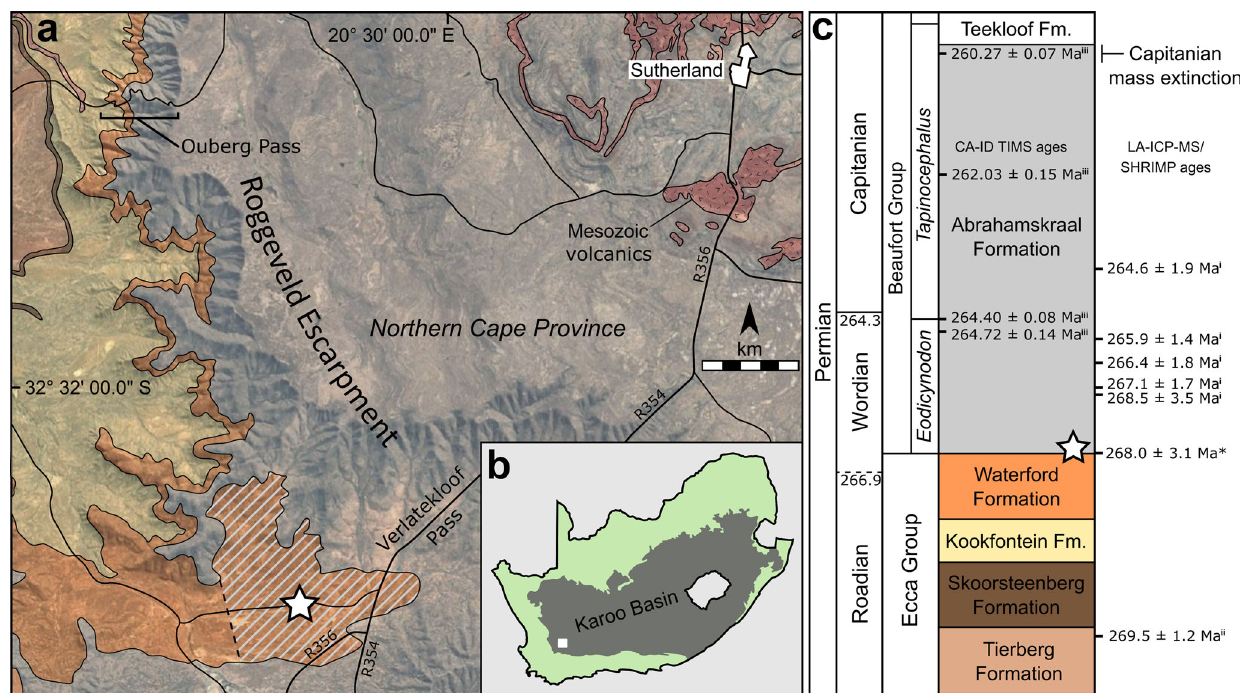
Fig. 2 Map and section showing the position of the Onder Karoo locality. a Geological map showing the Onder Karoo locality (white star) near the foot of Verlatekloof Pass, southwest of Sutherland. The diagonal hatching indicates exposure of probable lower Beaufort Group rocks that appear as Waterford Formation on the geological map of the region 40 . b Map showing the study area in the southwest of the Main Karoo Basin of South Africa. c Representative lithostratigraphic column of the upper Ecca Group and lower Beaufort Group showing the position of the locality and geochronology, after (i) 42 , (ii) 43 , (iii) 10 , and this study. Stratigraphy shows vertebrate assemblage zones within the Beaufort Group. Position of dated beds from different localities reconstructed using the correlations presented in ref. 10 . All ages quoted are U-Pb ages and while the weighted means of U-Pb dates determined through LA-ICP-MS and SHRIMP techniques may appear discordant with CA-ID TIMS U-Pb ages, they are in fact consistent when accounting for their higher error margins.